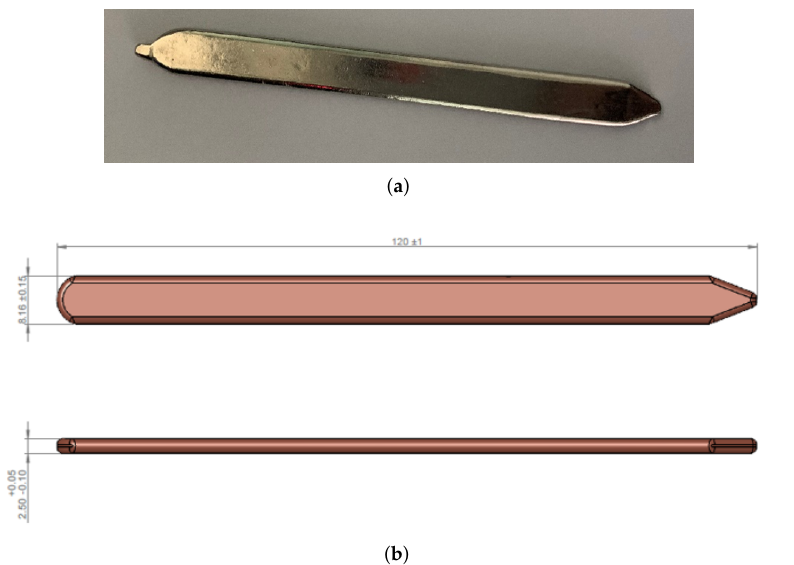
Figure 2. Picture and dimensions of the heat pipe used in the experimental test ( a ) Heat pipe picture. ( b ) Heat pipe